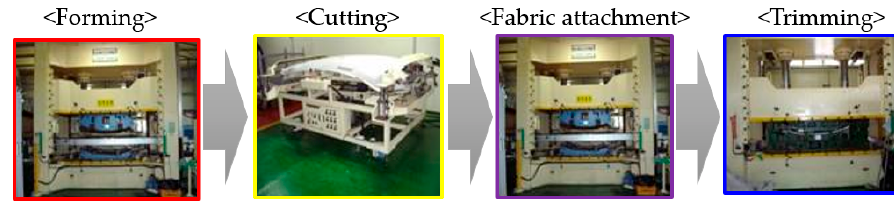
Figure 9. Forming process of headliner.